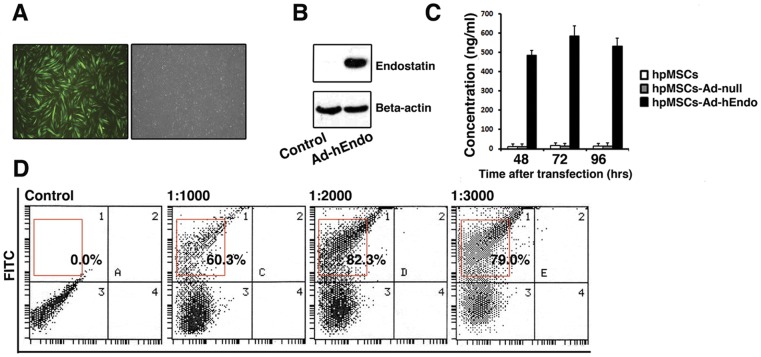
Fluorescence images of transduced hpMSCs and the expression of endostatin protein determined by ELISA and Western blots.A. GFP fluorescence was assessed in the FITC channel. The hpMSCs transfected with GFP-labeled adenovirus showed green. Original magnification×400. B. Cells transfected with Ad-hEndo and control adenovirus (Ad-null) at an MOI of 2000 were analyzed by Western blot to detect the expression of the endostatin protein. hpMSCs transfected with Ad-hEndo showed obvious expression of endostatin protein when compared with control. C. To verify the expression level of endostatin secreted by engineered hpMSCs in vitro, ELISA assay was performed to evaluate endostatin in the supernatants of cells transfected with adenovirus carrying endostatin, hpMSCs and hpMSCs transfected with Ad-null were applied as control. At 48 h, 72 h and 96 h post transfection, cell culture supernatants were collected and endostatin concentration were determined. The concentration of endostatin in the cell culture supernatants was significantly higher than the control groups and the level of endotatin also increased with time and remained at a high level 96 h after transfection. D. Flow cytometry was applied to evaluate the transfection efficiency of Ad-hEndo-GFP. The transfection rate at MOI 1000, 2000 AND 3000 was 60.3%, 82.3% and 79% respectively. Compared with the control, infection at an MOI of 2000 resulted in higher transfection efficiency. The red frame represents positive zone on each plot.